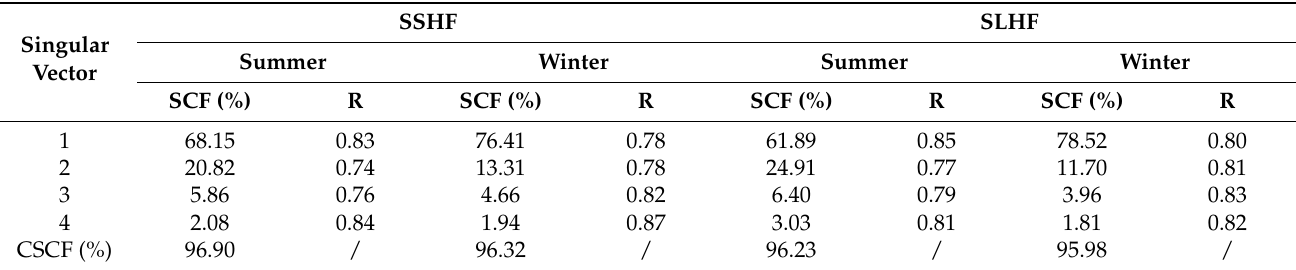
Table 3. SVD Analysis of surface flux and northward water vapor flux in Southeast